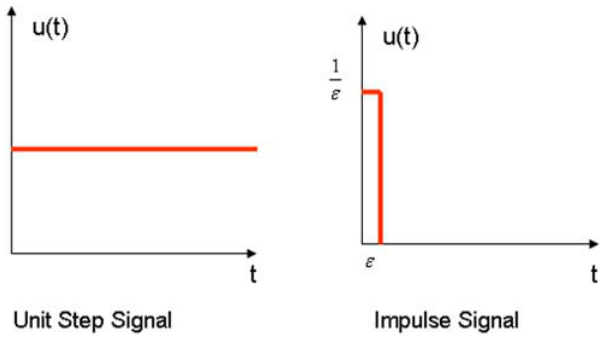
Figure 2. Unit step signal and impulse signal.